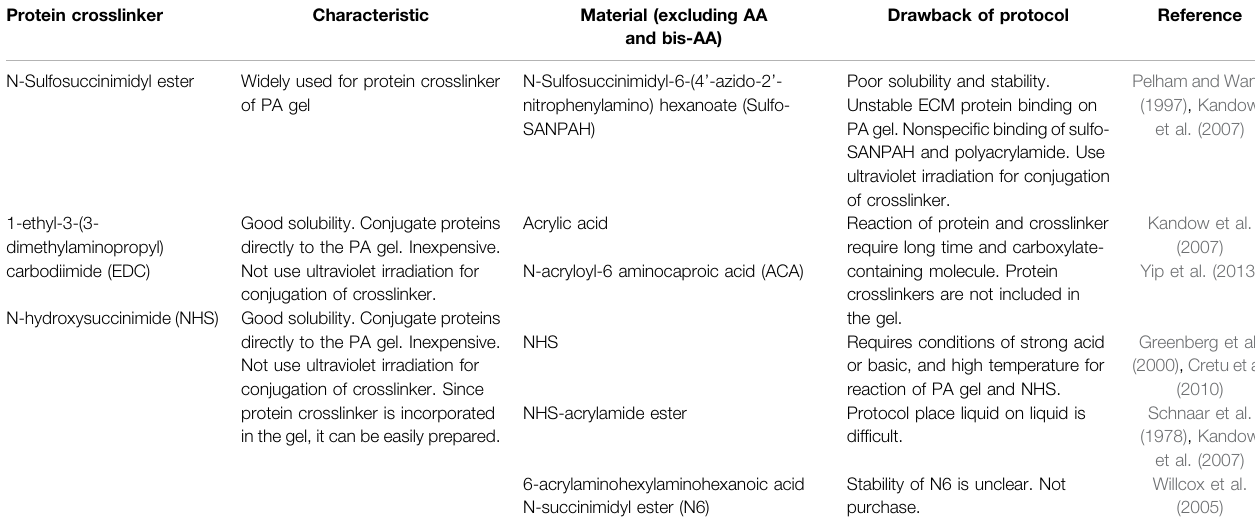
TABLE 1 | List of PA gel